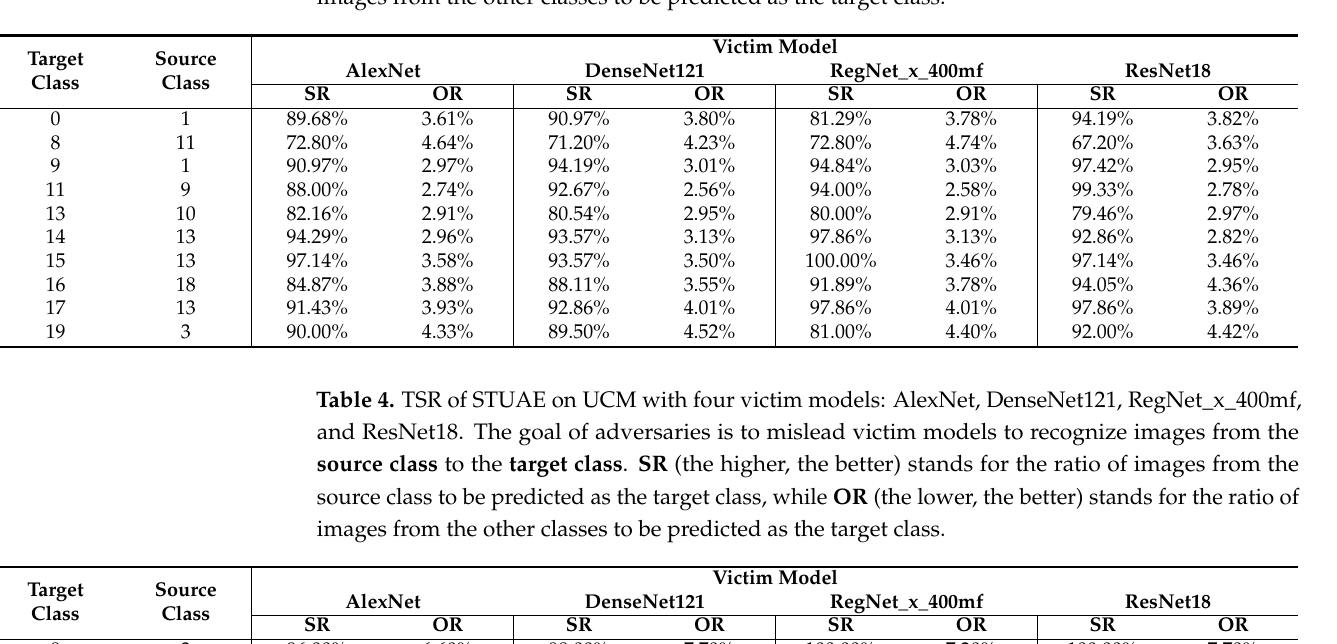
Table 3. TSR of STUAE on AID with four victim models: AlexNet, DenseNet121, RegNet_x_400mf, and ResNet18. The goal of the adversaries is to mislead victim models to recognize images from source class to the target class . SR (the higher, the better) stands for the ratio of images from the source class to be predicted as the target class, while OR (the lower, the better) stands for the ratio of images from the other classes to be predicted as the target class.